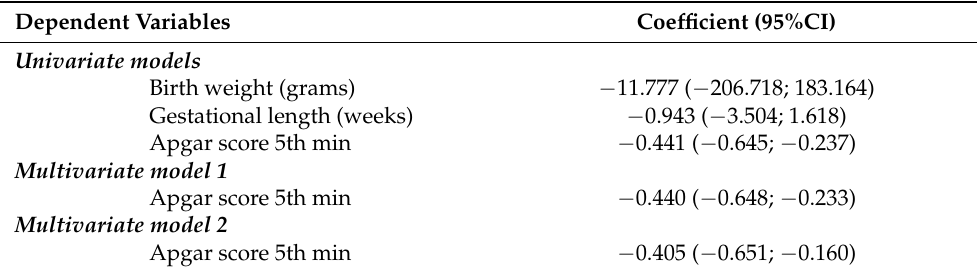
Model 1: Dependent variable: Apgar score 5th min; Independent variables: Σ DDT levels in umbilical blood and birth weight. Model 2: Dependent variable: Apgar score 5th min; Independent variables: Σ DDT levels in umbilical blood, birth weight and gestational